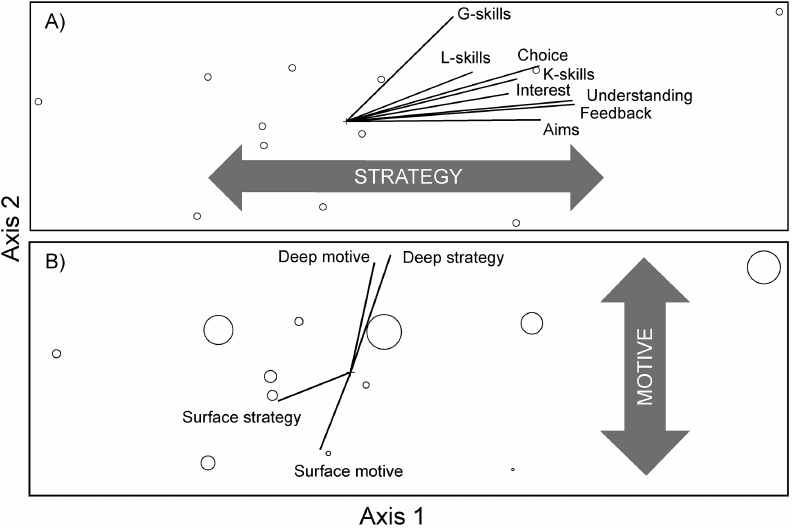
nor positive correlations between any secondary subscales (p > 0.000113; S1 Table) across sections. Multivariate trends among instruments Ordinations. In analyzing average student responses of primary subscales (e.g. Deep, Sur- face, ETL, and KLA) across our twelve sections, the final stress for a two-dimensional solution was 1.2067 (p = 0.0199), with a final instability of < 0.001 after 52 iterations (Fig 2). We rotated